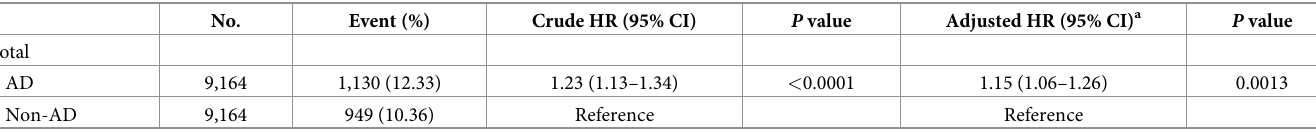
Table 2. Risk of GERD in patients diagnosed with AD.